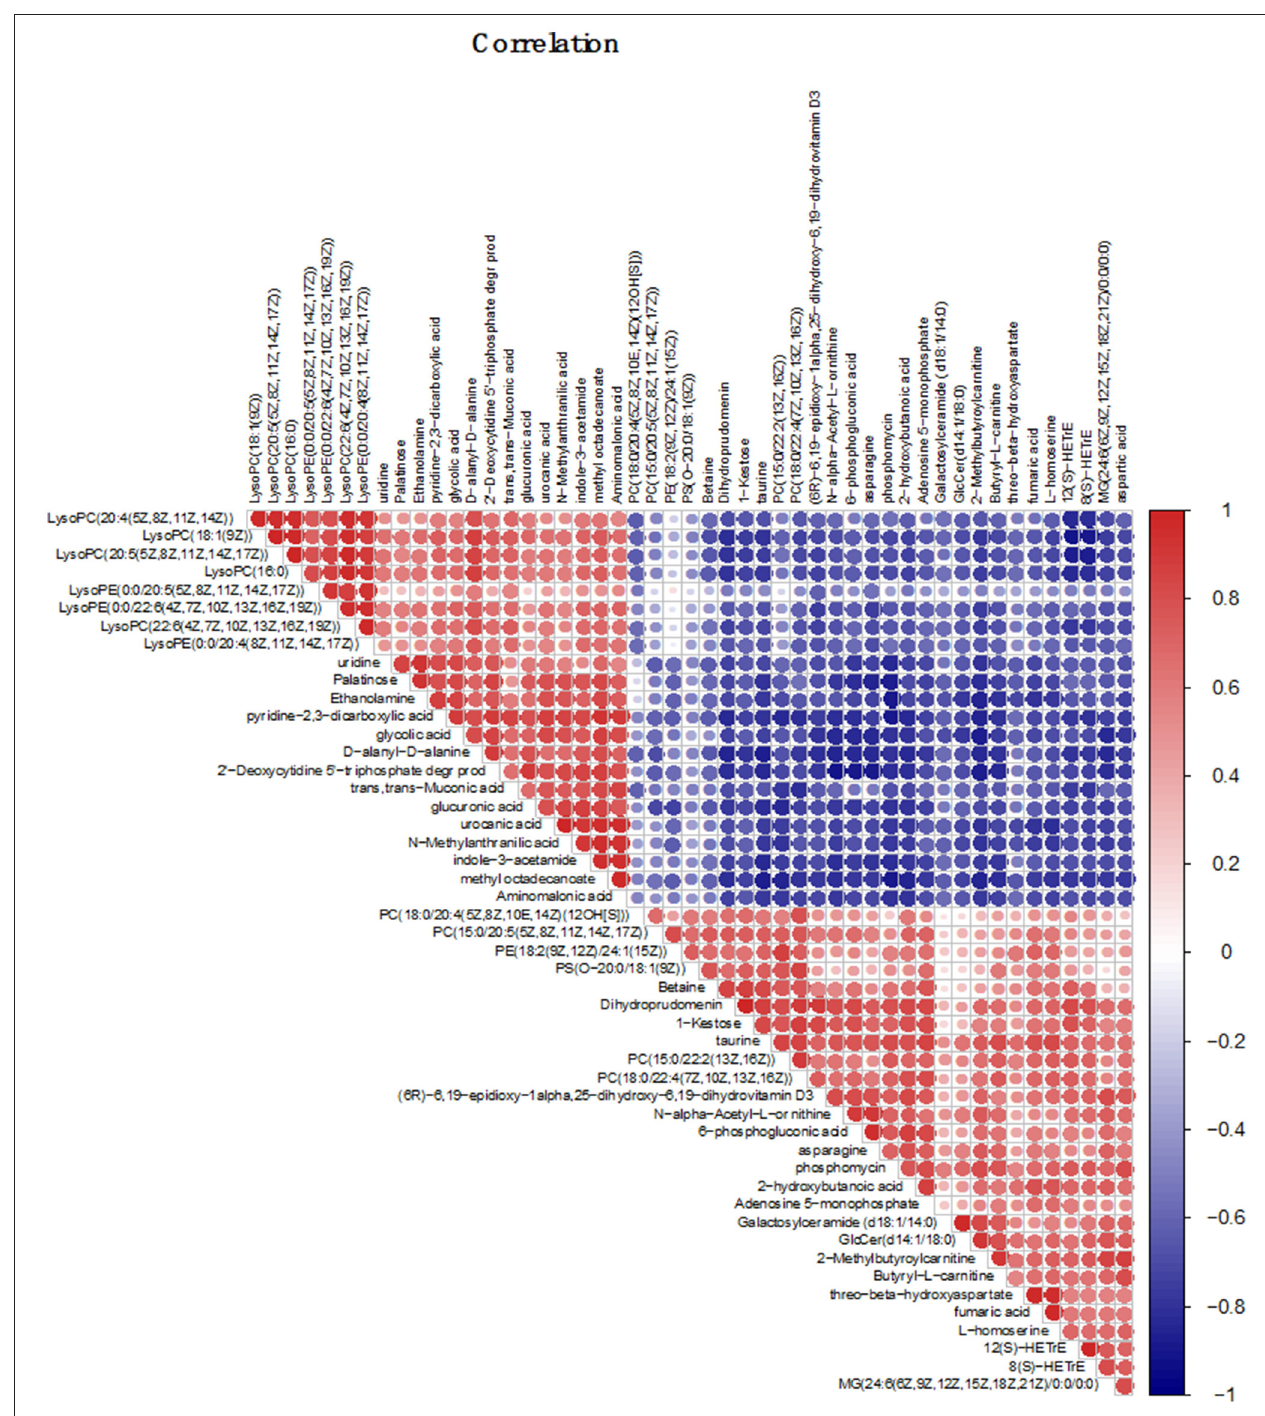
FIGURE 6 | Correlation analysis chart of the top 50 different metabolites; The correlation analysis graph represents a correlation between the expression levels of different substances, the red one represents the positive correlation, and the blue one represents the negative correlation. The darker the color, the larger the dot, and the higher the correlation